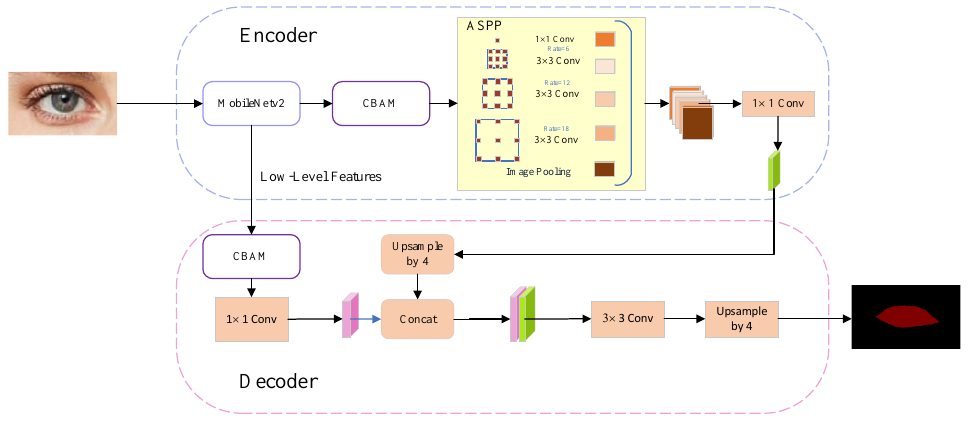
Figure 3. The architecture of the Deeplabv3+ Model with Attention Mechanisms for eye image Figure 3. segmentation.